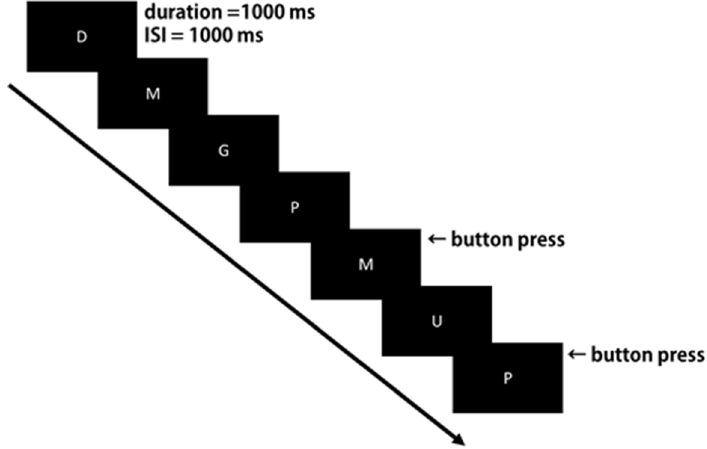
Figure 1. Experimental design of the letter 3-back working memory task.